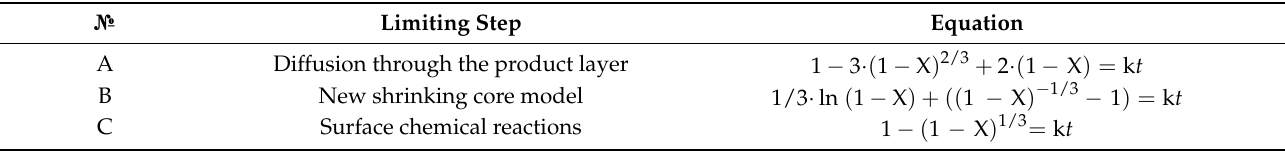
Table 4. The shrinking core model (SCM) Equations.